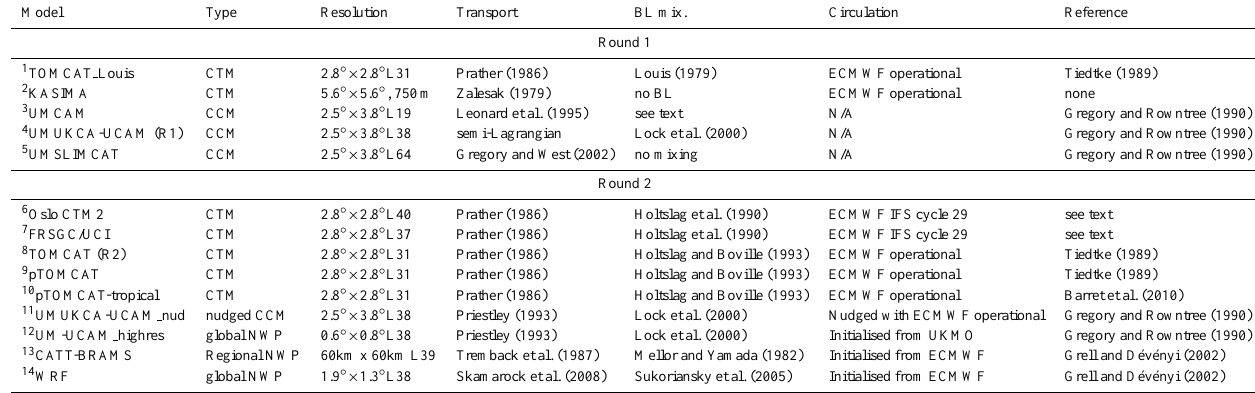
Table 1. The models which participated in the inter-comparison. The models were run at the following institutions: 1 , 5 , 8 University of Leeds, 2 Karlsruhe Institute of Technology, 3 , 4 , 9 , 10 , 11 , 12 University of Cambridge, 6 University of Oslo, 7 Lancaster University, 13 M´et´eo-France and CNRS and University of Orl´eans, 14 University of